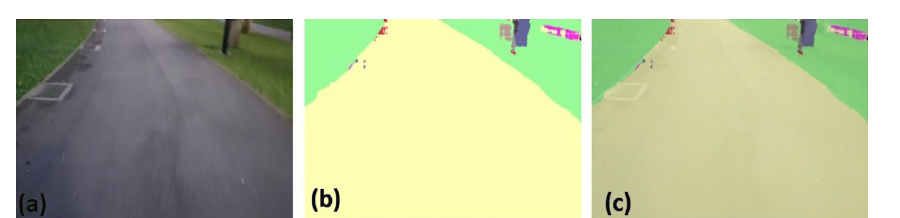
Figure 32. DeepLabv3+ segmentation results.